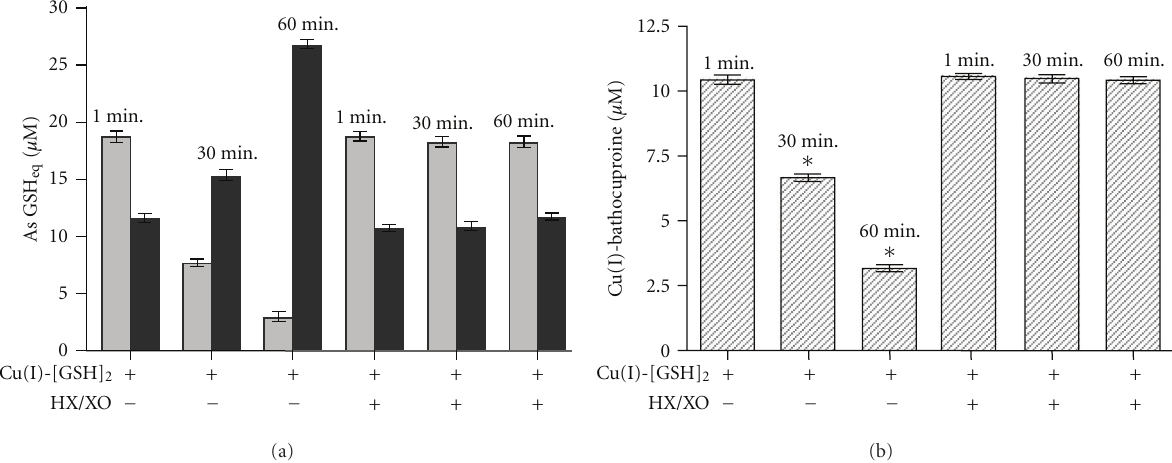
∗∗ Figure 7: (a) E ff ect of the exposure of Cu(I)-[GSH] 2 to an exogenous source of superoxide radicals on the thiol-titratable groups and EDTA-releasable GSSG. Hypoxanthine (0.2mM) plus xanthine oxidase (XO; 2 U/mL) were added to a solution containing the Cu(I)- [GSH] 2 complex (10 μ M), and the mixture was incubated for 0–60 min, at 30 ◦ C. Samples were taken from the incubation media after 1, 30, and 60 min and analyzed for their TTG (light grey bar) and EDTA-releasable GSSG (dark grey bar) levels. Results are expressed as GSH equivalents ( μ M). (b) E ff ect of the exposure of Cu(I)-[GSH] 2 to an exogenous source of superoxide radicals on the concentration of copper (I). Hypoxanthine (0.2mM) plus xanthine oxidase (XO; 2 U/mL) were added to a solution containing the Cu(I)-[GSH] 2 complex (10 μ M) and the mixture was incubated for 0–60 min, at 30 ◦ C. Samples were taken from the incubation media after 1, 30, and 60min and analyzed for their Cu(I) concentration. Results are expressed as Cu(I)-bathocuproine ( μ M). The asterisk on the bars indicate that such values are statistically di ff erent, at the level of a P < 0 . 001, from all other values. the corresponding increments in the EDTA-releasable